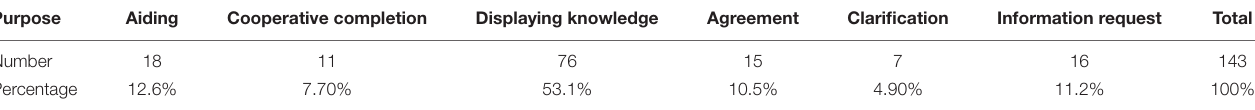
TABLE 5 | Frequency of